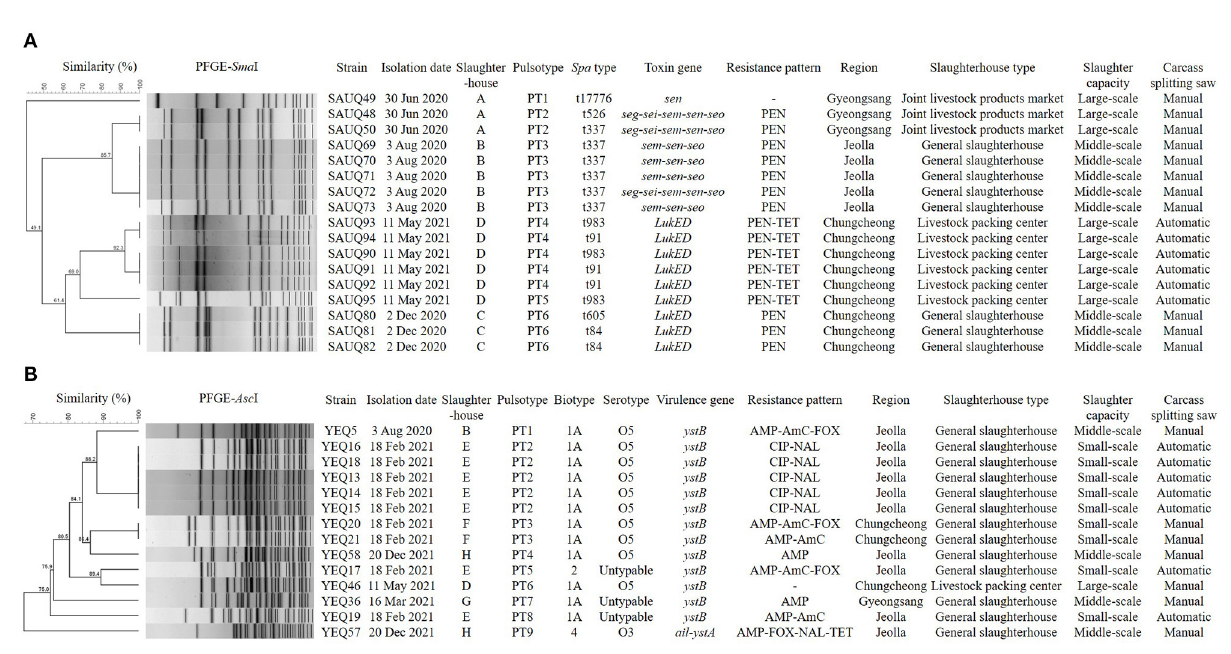
FIGURE1 Dendrogram showing genetic relationships among the strains characterized by PFGE profiles (A) Staphylococcus aureus , (B) Yersinia enterocolitica . Showing similarities of < 90% in PFGE were considered to be unrelated. The types of slaughterhouses are divided into Livestock packing center (slaughterhouse for slaughter, processing, and sale), Joint livestock products market (slaughterhouse for slaughter and sale), and General slaughterhouse (slaughterhouse for slaughter). Slaughter capacities (pigs/day) are divided into small-scale ( ≤ 900), middle-scale (901–1,500), and large-scale ( ≥ 1,501). PEN, Penicillin; TET, Tetracycline; AMP, Ampicillin; AmC, Amoxicillin/ Clavulanic acid; FOX, Cefoxitin; CIP, Ciprofloxacin; NAL, Nalidixic